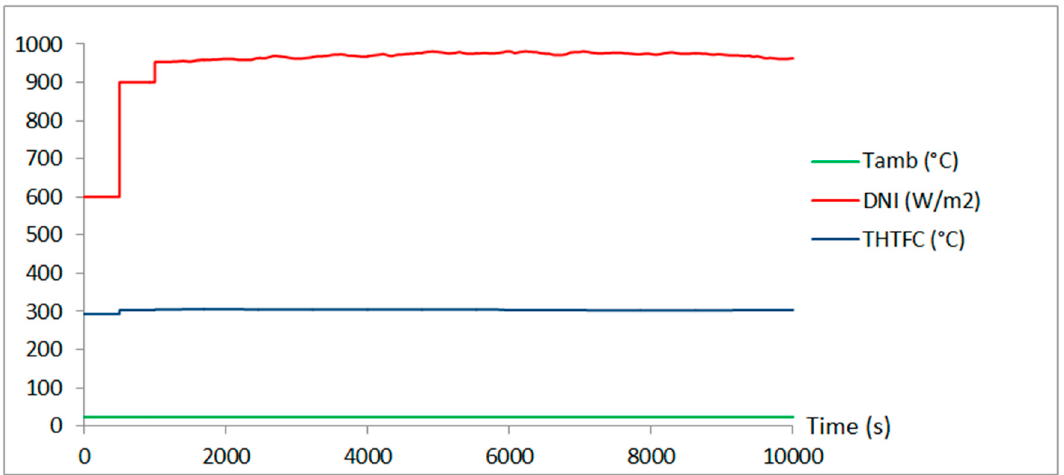
Figure 3. Real input variables (La Africana—September 2010).